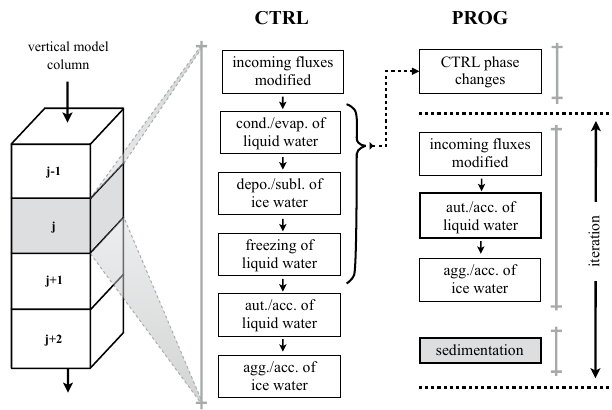
Figure 1. Schematic flowchart of the CTRL and PROG micro- physics schemes. The gray vertical bars denote vertical loops (illus- trated by the vertical model column on the left), the boxes in bold are new or changed schemes, and the sedimentation can be subject to a further time splitting if